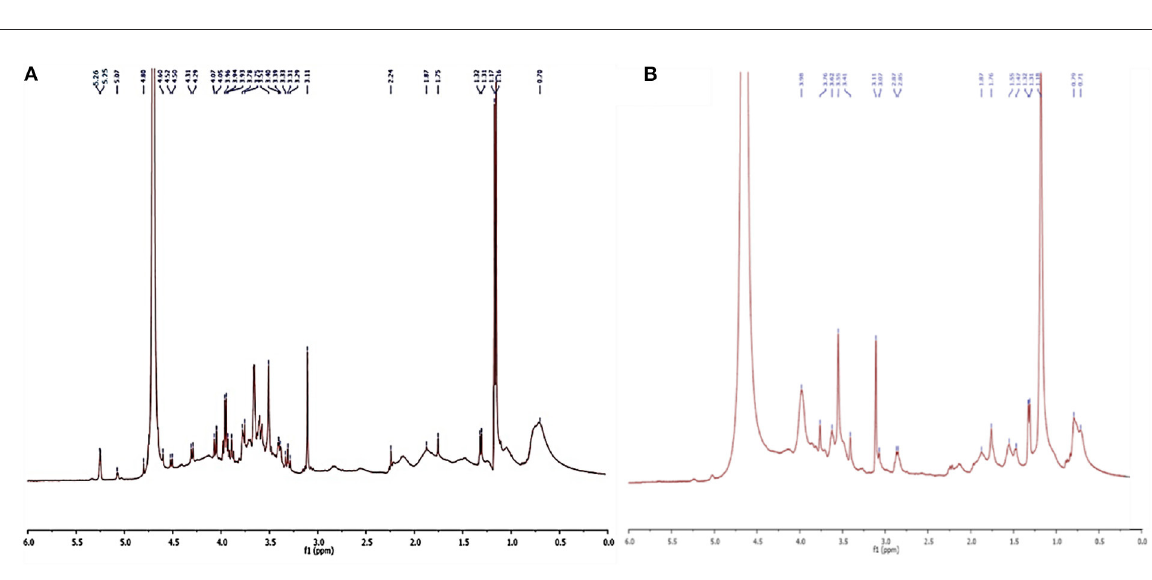
ppm (Figure 5A) and 3.98 to 3.07 ppm (Figure 5B) were assigned to the olefinic protons of double bonds and also indicating the presence of fractions of polysaccharides (4, 44). The range between 3 and 0.7 ppm corresponds to the presence of glucan– protein structure considering the N–CH 3 and N–H groups